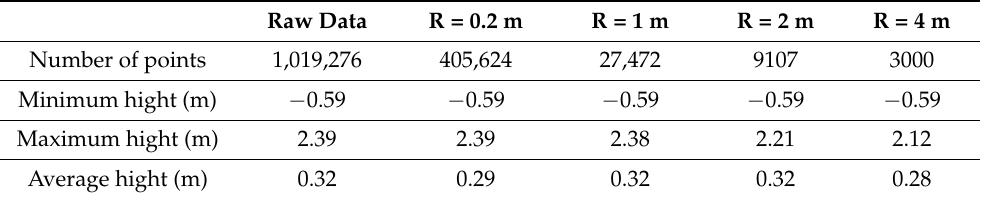
Table 4. The reduction results for UAS